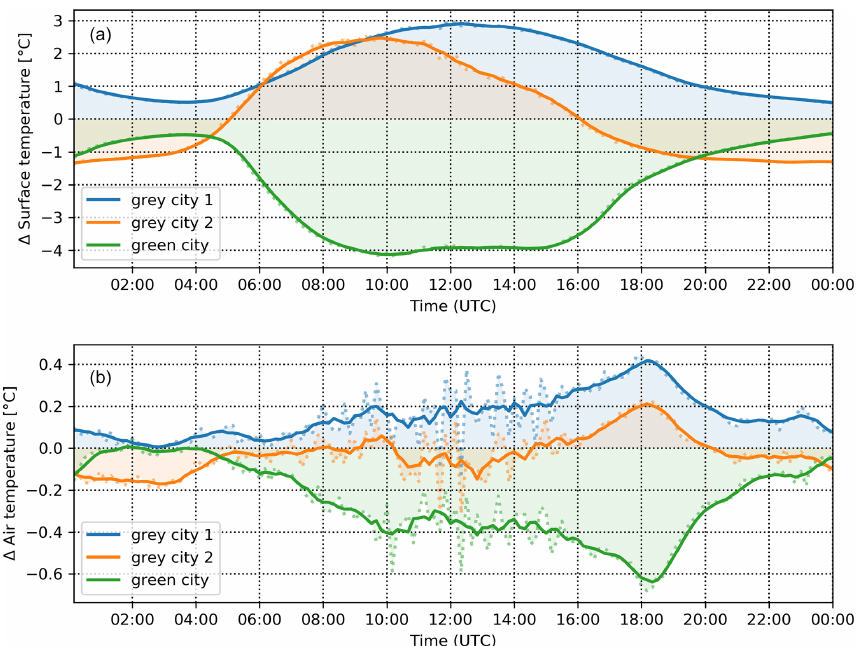
Figure 9. Domain-averaged differences in the surface temperature (a) and air temperature (b) for grey-city scenarios SB10 (blue) and SB11 (orange) and green-city scenario SB12 (green). Dotted lines: 10min values; solid lines: 1h moving